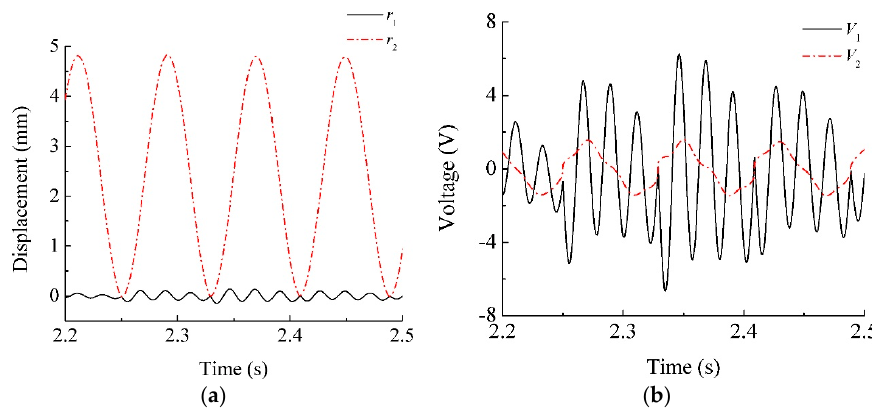
Figure 4. The simulated time-domain responses of the piezoelectric and magnetic oscillators. ( a ) Relative tip displacements to the base; ( b ) Open-circuit voltages.